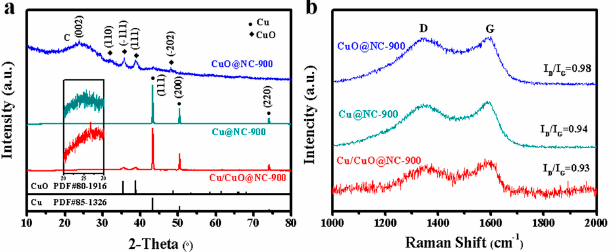
Figure 2. ( a ) XRD patterns (Inset: XRD partial magnification of Cu/CuO@NC-900 and Cu@NC-900) and ( b ) Raman spectra of CuO@NC-900, Cu@NC-900 and Cu/CuO@NC-900 electrocatalysts.